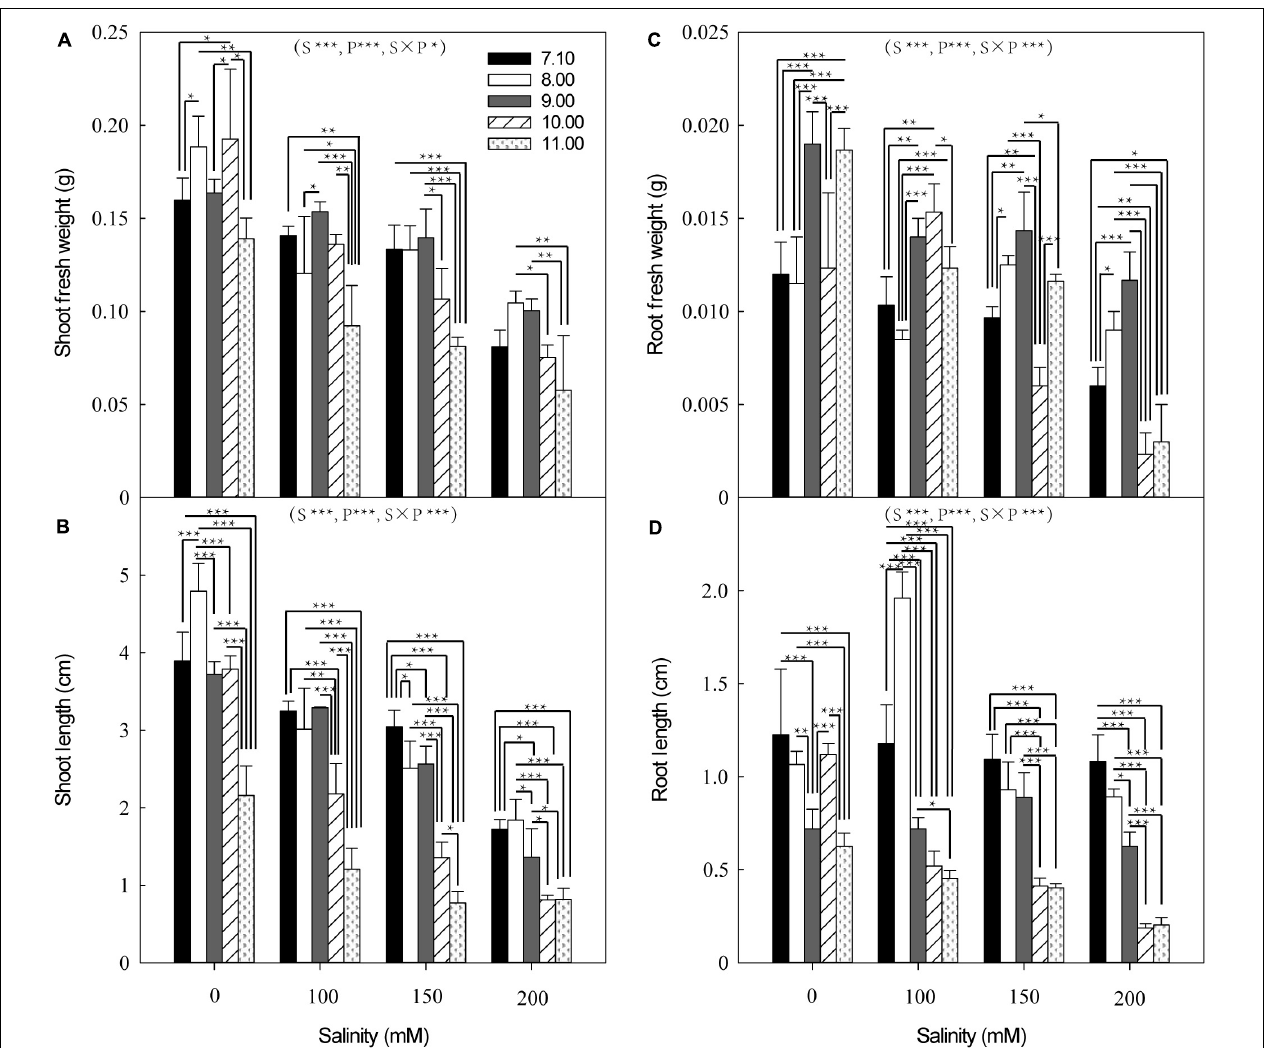
FIGURE 4 | Interactive effects of NaCl and pH on shoot fresh weight (A) , root fresh weight (B) , shoot length (C) , and root length (D) of canola seedling 7 days of germination. S is salinity, P is pH, and S × P is their interaction, *, **, and *** indicate significance at P = 0.05, 0.01, and 0.001, respectively, according to the least significant difference (LSD) test for simple effects analysis of two-way ANOVA interactions ( P <